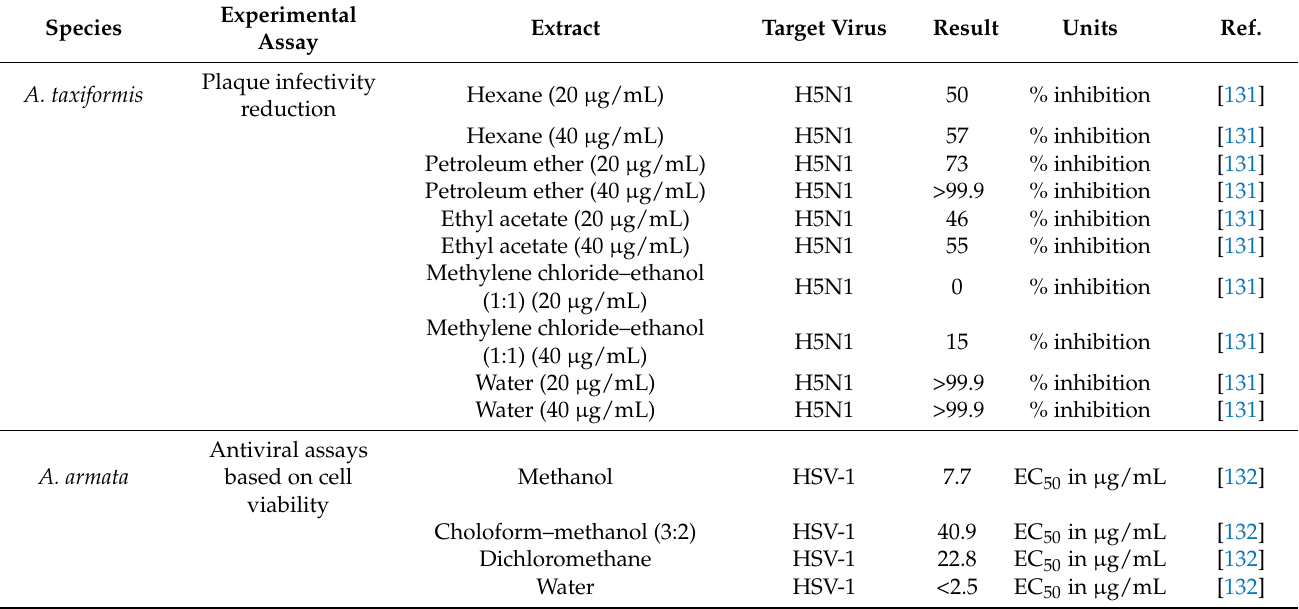
Table 4. Antiviral activity of Asparagopsis